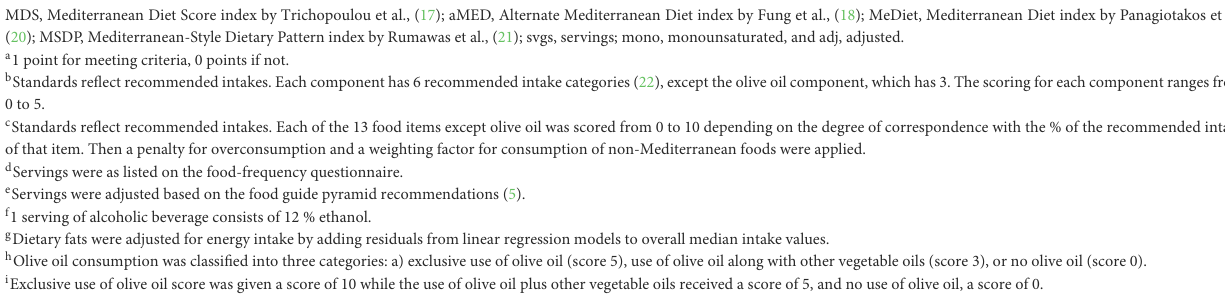
The MDS and aMED indices were chosen for these analyses as two of the most frequently used instruments that rely on median food intakes in the population. The MeDiet and MSDP indices were chosen as two indices reflecting adherence to recommended intakes of relevant foods from the Mediterranean diet pyramid.